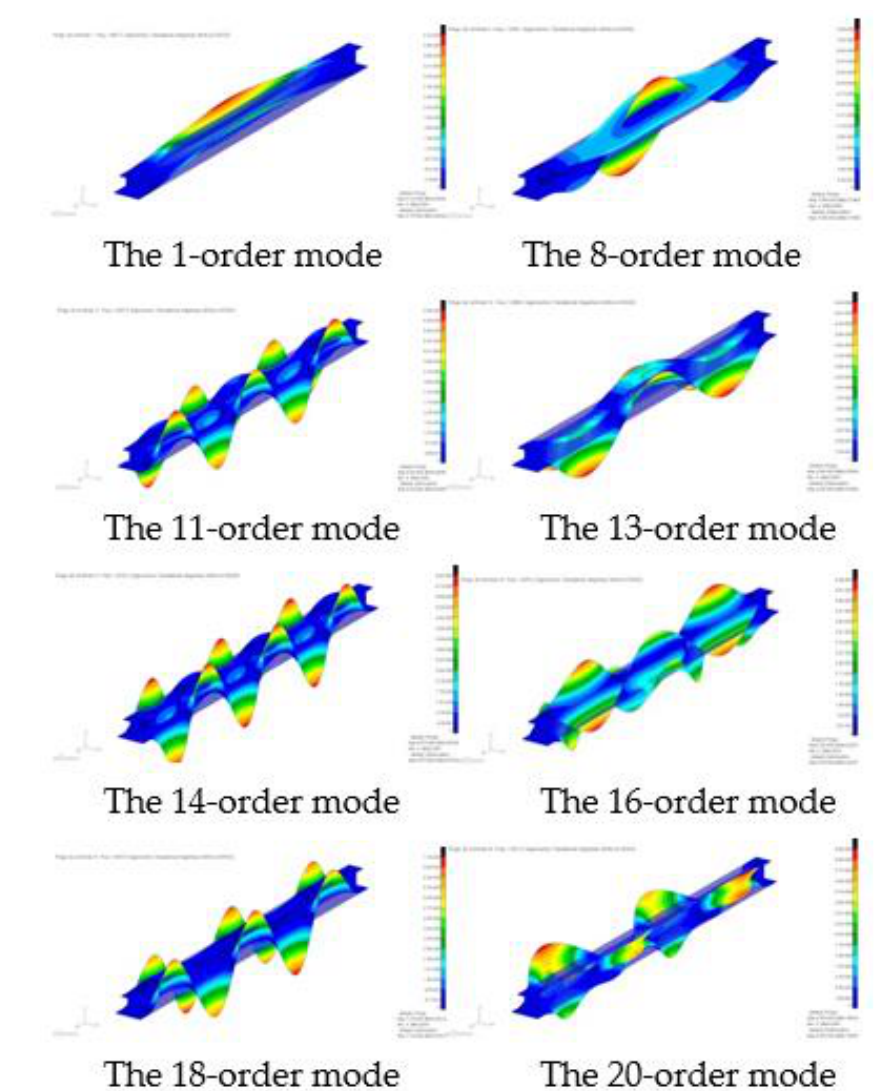
Figure 7. The typical modes of the I-shape composite beam.